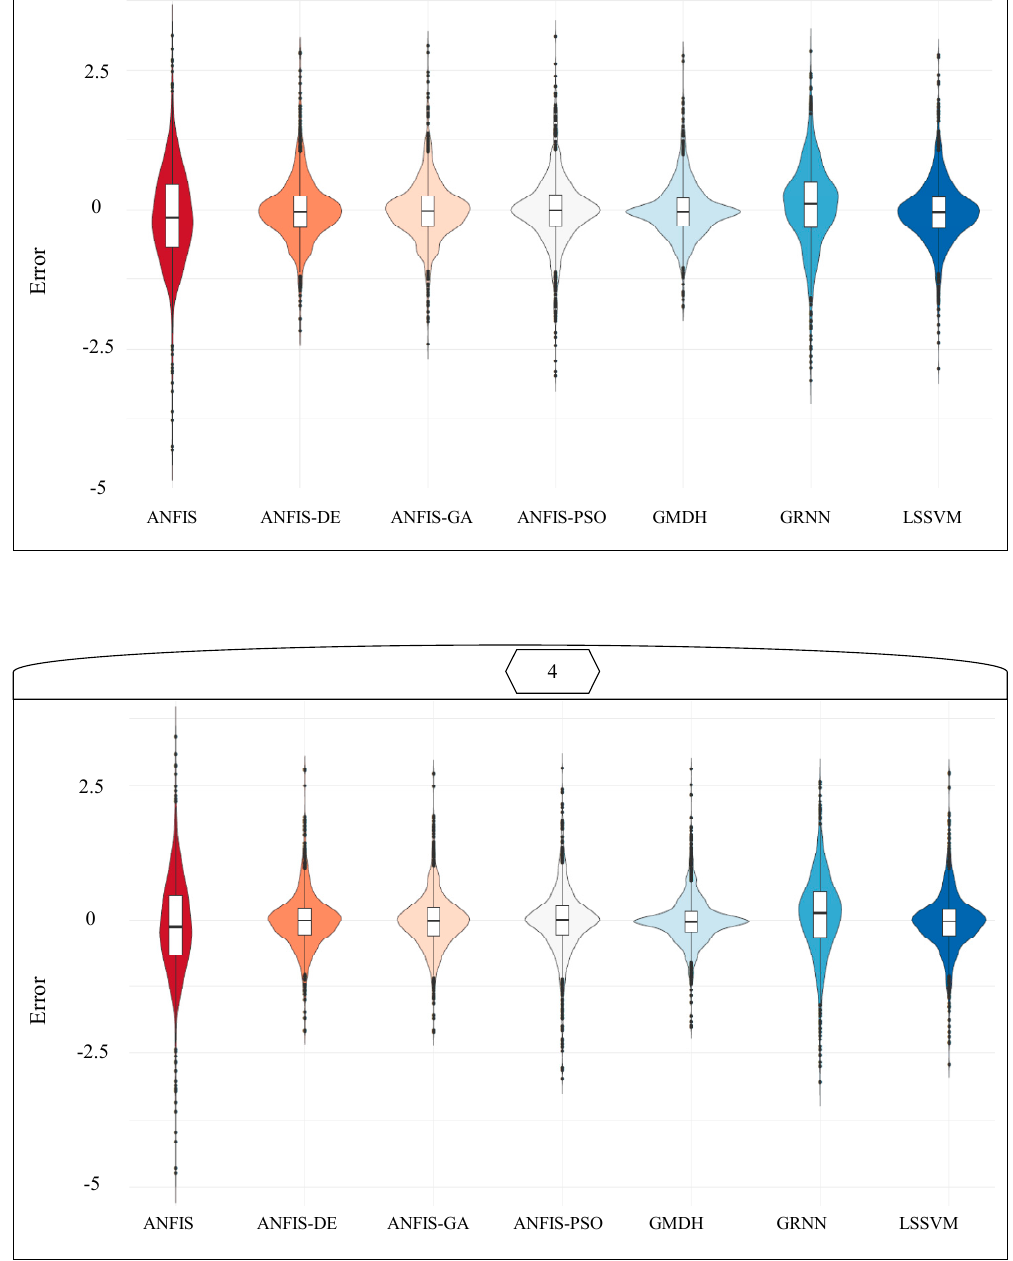
Figure 7. Violin plots of the errors; Total evaluation of JDI’s prediction error resulted by inputs of gamma test (1) and entropy theory (2) and total evaluation of MSPI’s prediction error resulted by inputs of gamma test (3) and entropy theory (4).